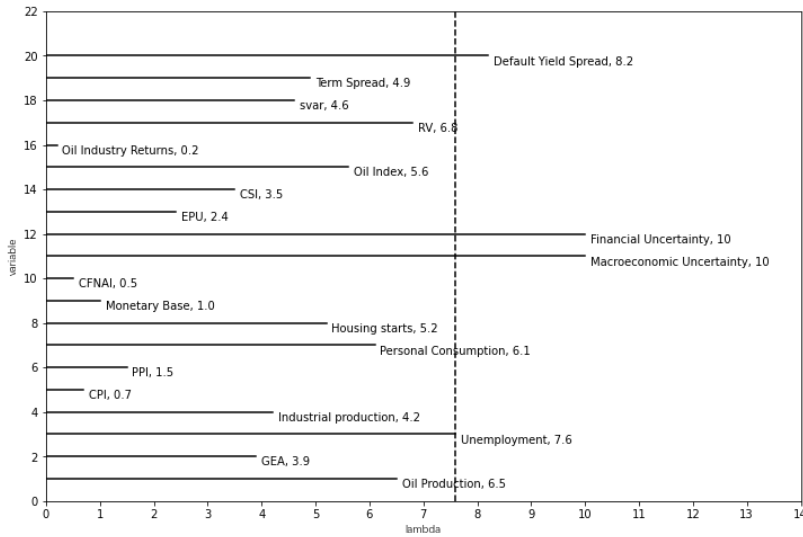
Figure 2. Shows the value of λ for each variable when the coefficient θ drops to zero.